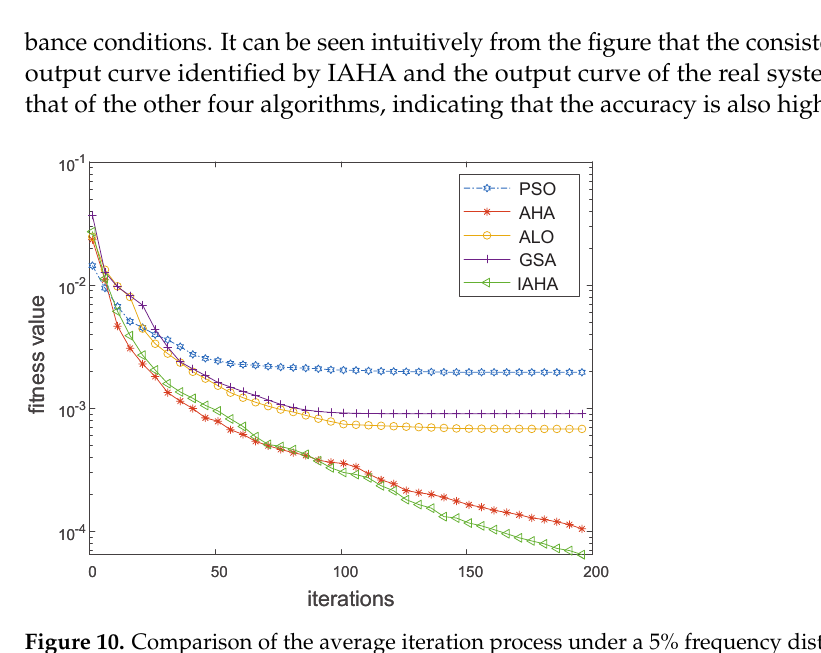
Figure 10. Comparison of the average iteration process under a 5% frequency disturbance condition.